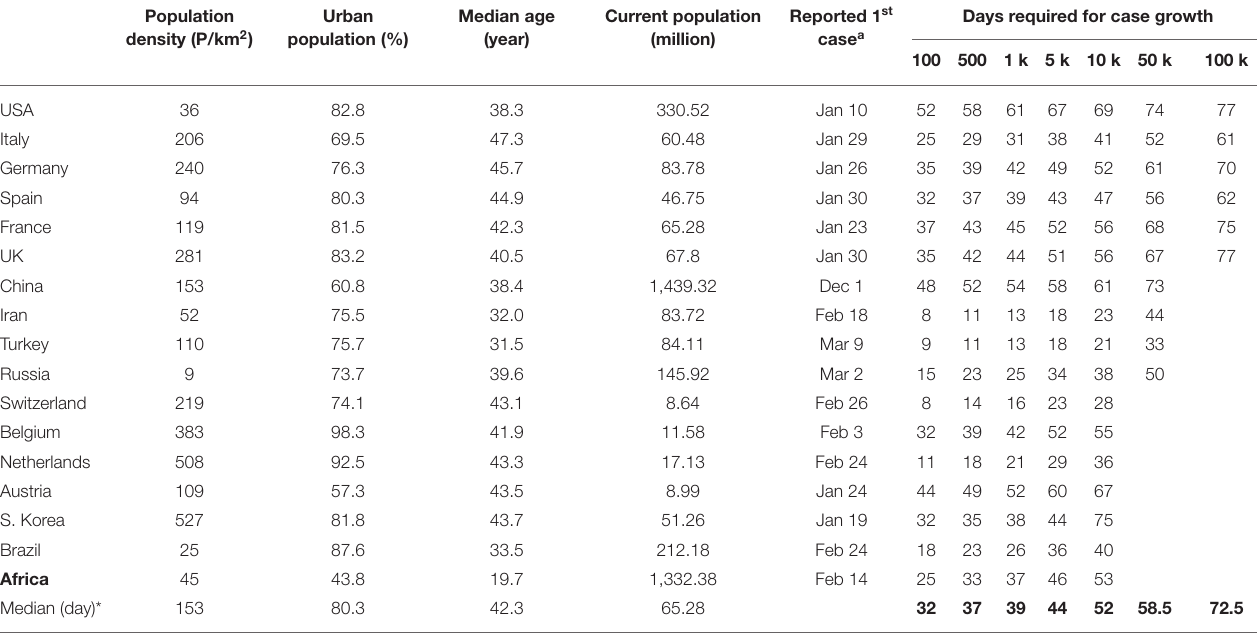
TABLE 1 | Population characteristics and transmission dynamics of COVID-19 in some countries. Population density (P/km 2